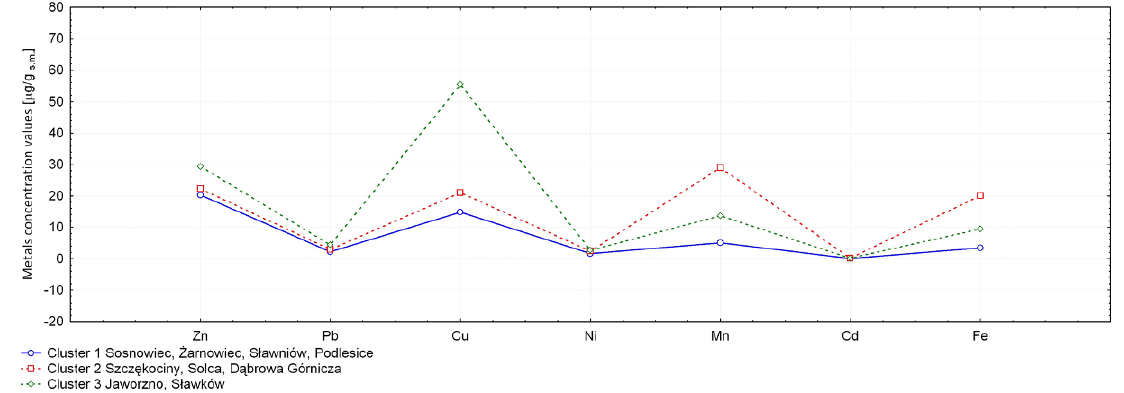
Figure 7. k-means analysis diagram for metal content in relation to the sampling